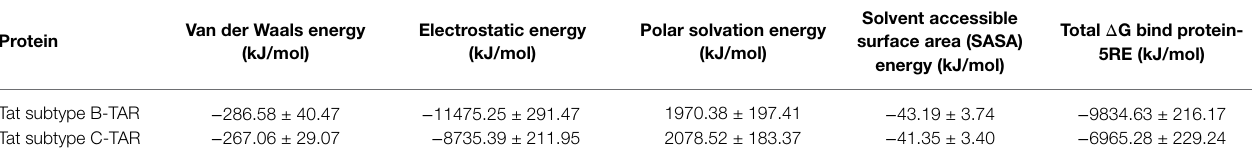
TABLE 3 | Molecular Mechanics Poisson–Boltzmann Surface Area (MMPBSA) energy parameter contributions to the total binding free energy. Solvent accessible Van der Waals energy Electrostatic energy Polar solvation energy Protein surface area (SASA) (kJ/mol) (kJ/mol) (kJ/mol) energy